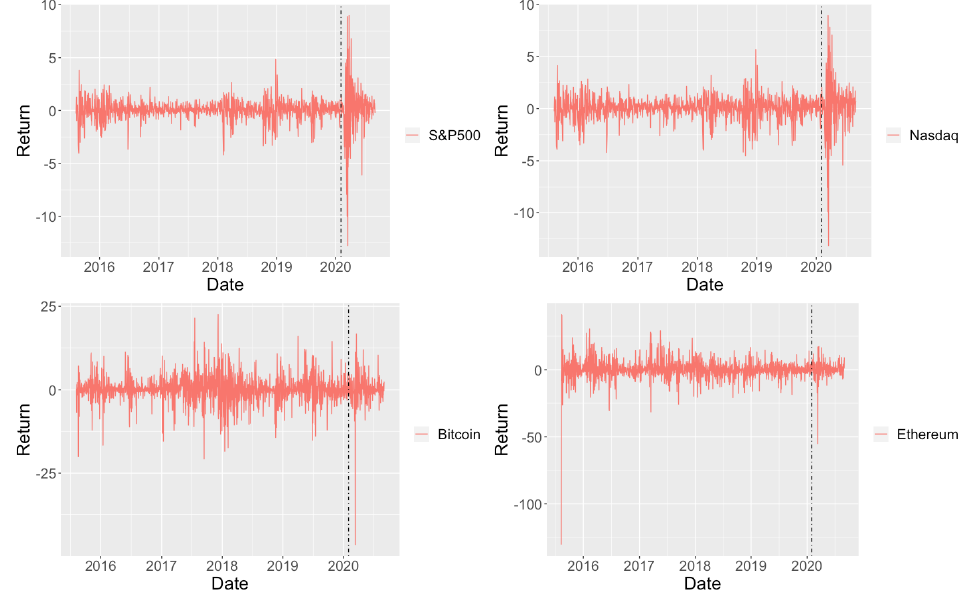
Figure 1. Plot of price, volume and daily